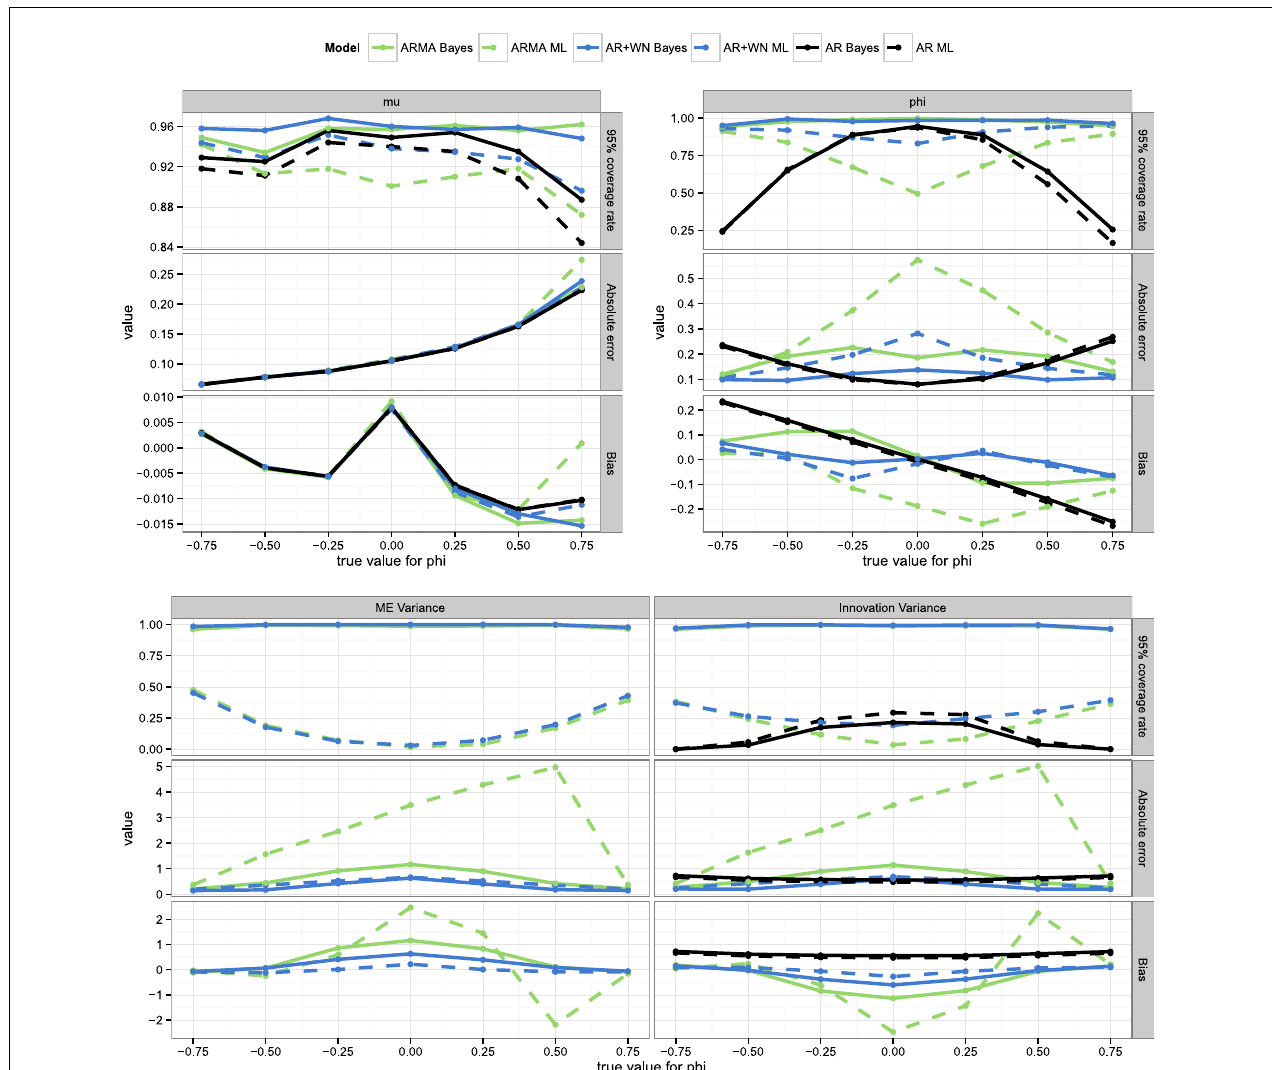
FIGURE 3 | Coverage rates, absolute errors, and bias for the parameter estimates for the frequentist and Bayesian AR(1), ARMA(1,1), and AR(1) + WN models across different values for φ